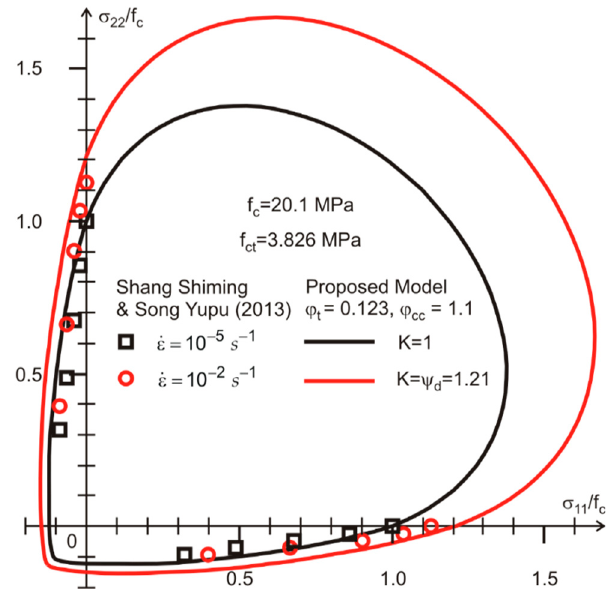
Figure 11. Comparison of the proposed dynamic strength criterion with experimental results by Shiming and Yupu [51] for biaxial tensile–compressive loading tests.